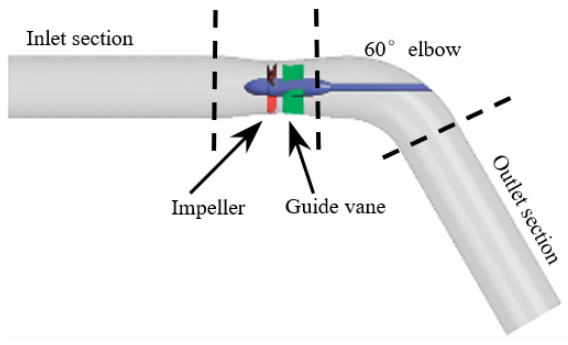
Figure 1. Three-dimensional model of the pump